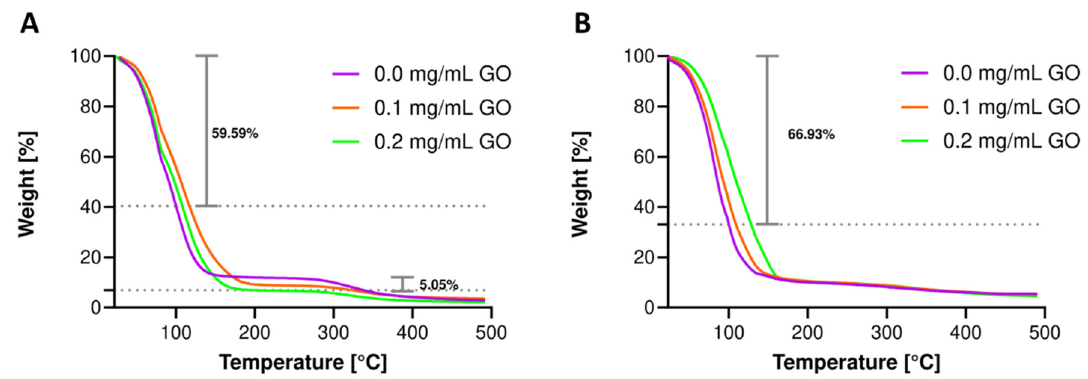
Figure 7. The average weight (%) loss at 100 °C is indicated on each plot. Thermograms for hydrogels with 7.5% ( w / v ) gelatin concentration and GTA concentration of 3.0% ( w / w ). Thermal degradation for hydrogels without any treatment ( A ) and after 72 h milli-bioreactor operation ( B ).